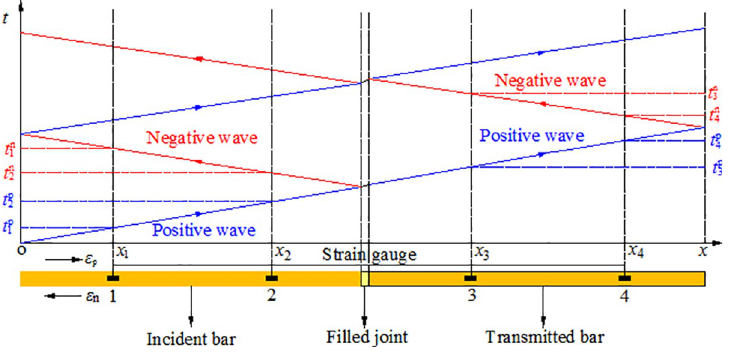
Fig 9. Schematic diagram of the wave separation in rock